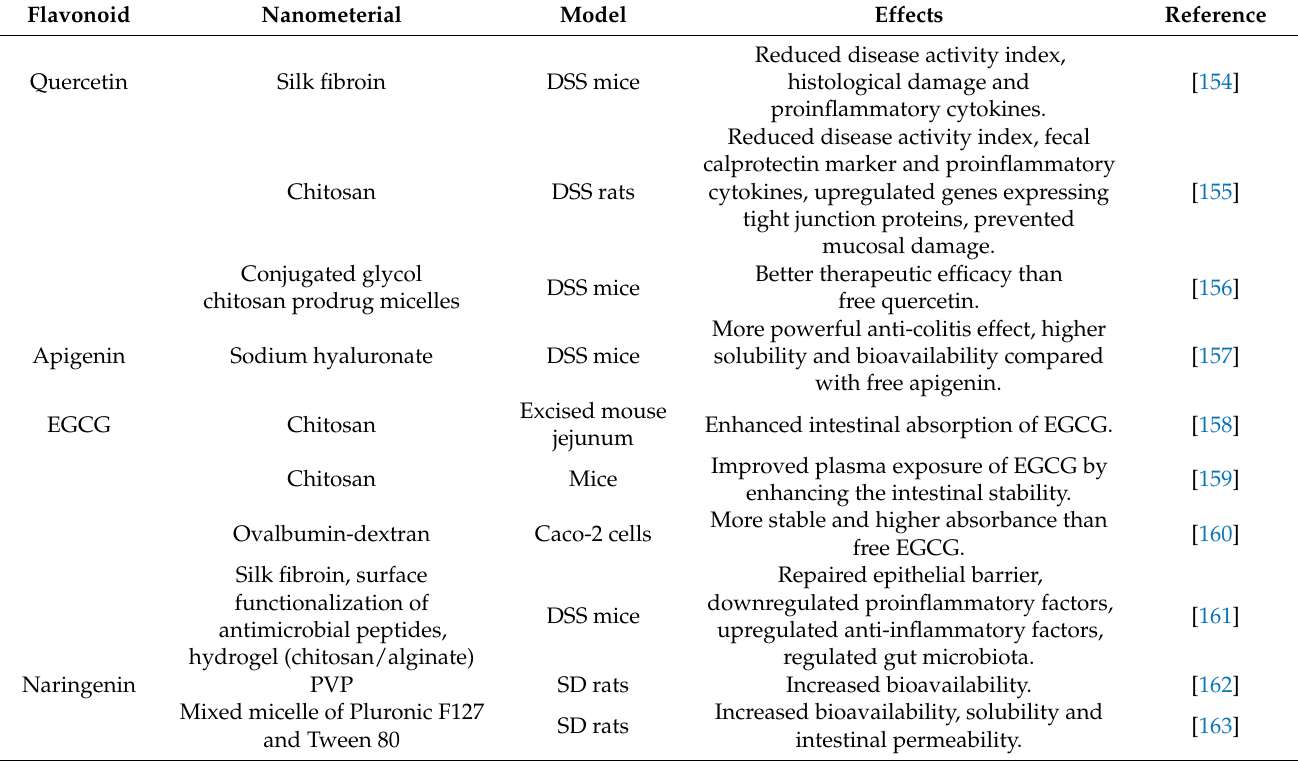
Table 2. Flavonoids loading in nanoparticles for IBD